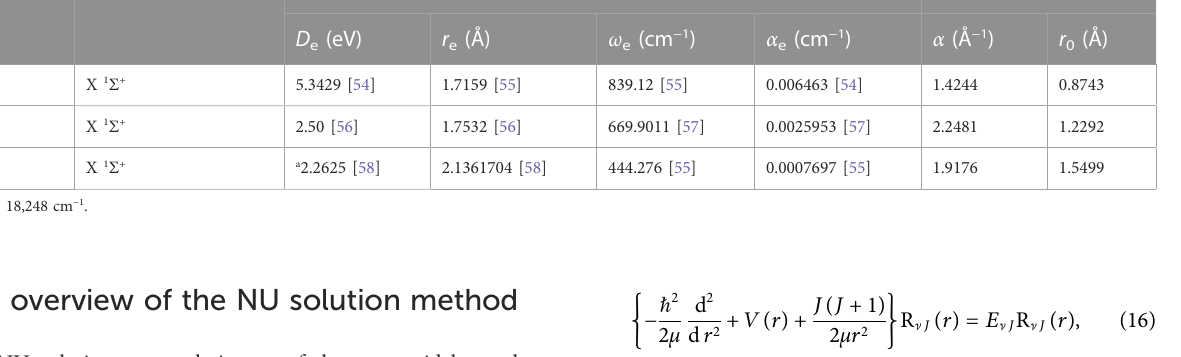
TABLE 1 Molecular and potential parameters of the diatomic molecules analyzed in this work. Molecule Molecular